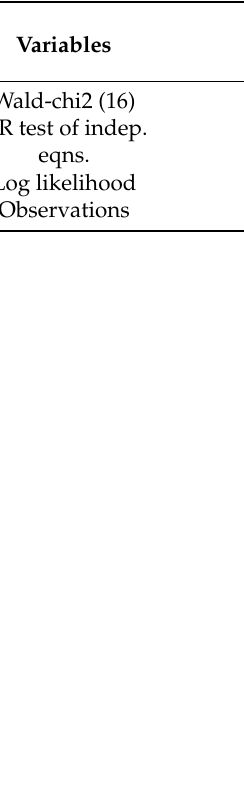
Table 8. The impacts of RPM on